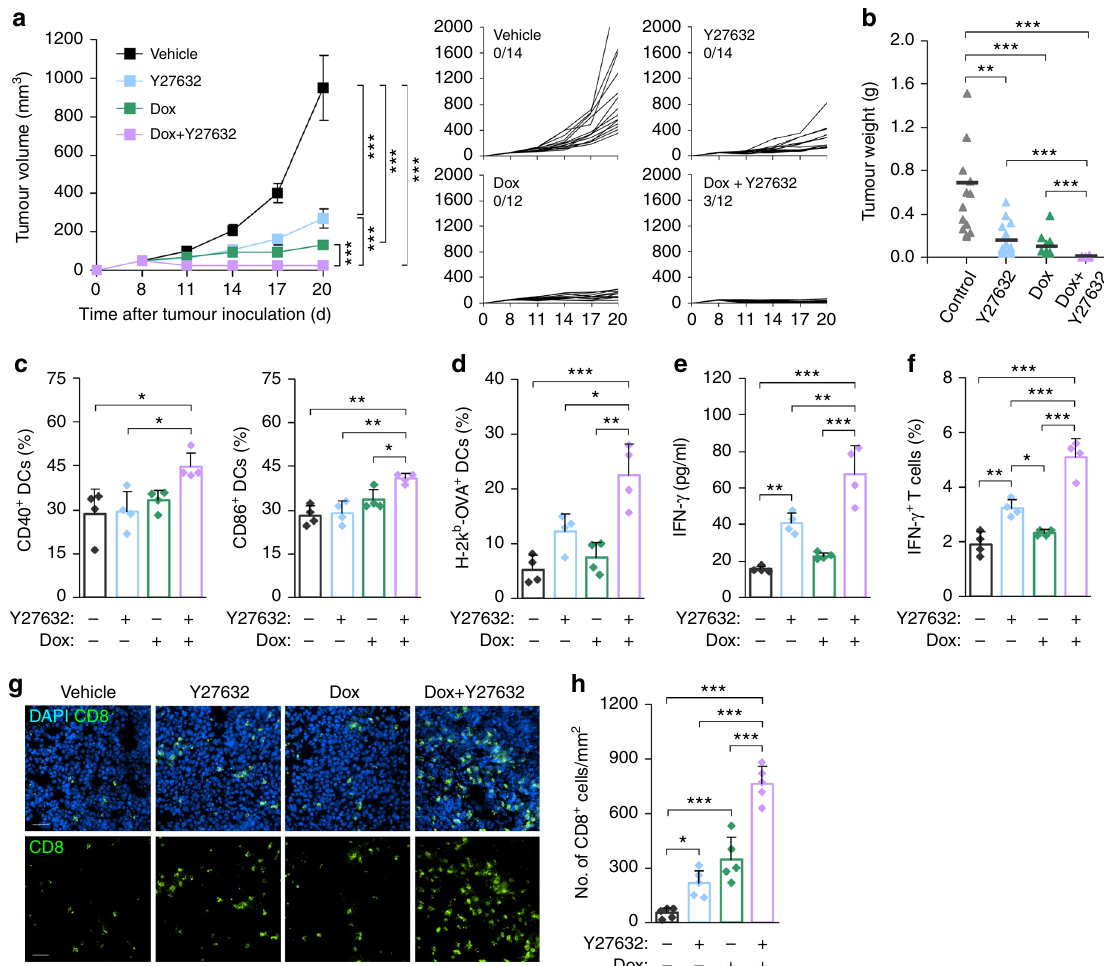
Fig. 6 Combined therapy effectively induces antitumour immunity. a , b B16F10-Ova tumour-bearing C57BL/6 mice were injected (i.v.) with Y27632 (10 mg kg − 1 ) and/or Dox (5 mg kg − 1 ), as indicated in Supplementary Fig. 19. a Tumour volume was measured at the indicated times. Data are presented as means ± s.e.m. (left panel) and tumour growth curves of individual mice (right panels). Fractions indicate the number of mice showing complete tumour regression. b Tumour weights in individual mice were analysed at the end of the experiment. Bars indicate mean values ( n = 12 – 14). c The percentage of CD40 + and CD86 + DCs among tumour-draining LN cells from B16F10-Ova tumour-bearing C57BL/6 mice treated Y27632 and/or Dox was analysed by fl ow cytometry. Data are presented as means ± s.d. ( n = 4). d Tumour-draining LN cells were isolated from B16F10-Ova tumour-bearing C57BL/6 mice treated with Y27632 or vehicle, and the percentage of H-2k b -OVA + DCs was analysed by fl ow cytometry using an antibody recognizing a complex of the ovalbumin peptide (SIINFEKL) with H-2k b (MHC-I). Data are presented as means ± s.d. ( n = 4). e CD11c + DCs were isolated from tumour-draining LNs from B16F10-Ova tumour-bearing C57BL/6 mice treated with Y27632 and/or Dox and co-cultured with OT-I T cells for 72 h; secreted IFN- γ was analysed by ELISA. Data are presented as means ± s.d. ( n = 4). f CD11c + DCs were isolated from tumour-draining LNs from B16F10-Ova tumour-bearing C57BL/6 mice treated with Y27632 and/or Dox and co-cultured with OT-I T cells. The percentage of IFN- γ -producing CD8 + T cells was analysed by fl ow cytometry. Data are presented as means ± s.d. ( n = 4). g , h B16F10-Ova tumour-bearing C57BL/6 mice were injected (i.v.) with Y27632 and/or Dox. On day